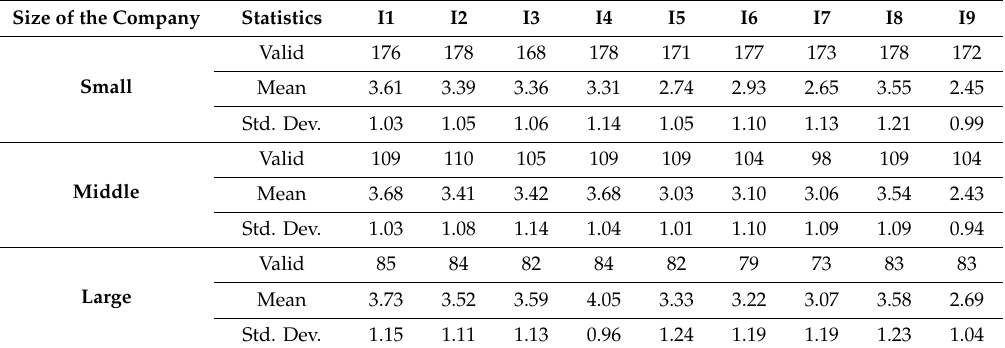
Table 5. Average scores of items in the phase of strategy according to size of the company. Size of the Company Statistics